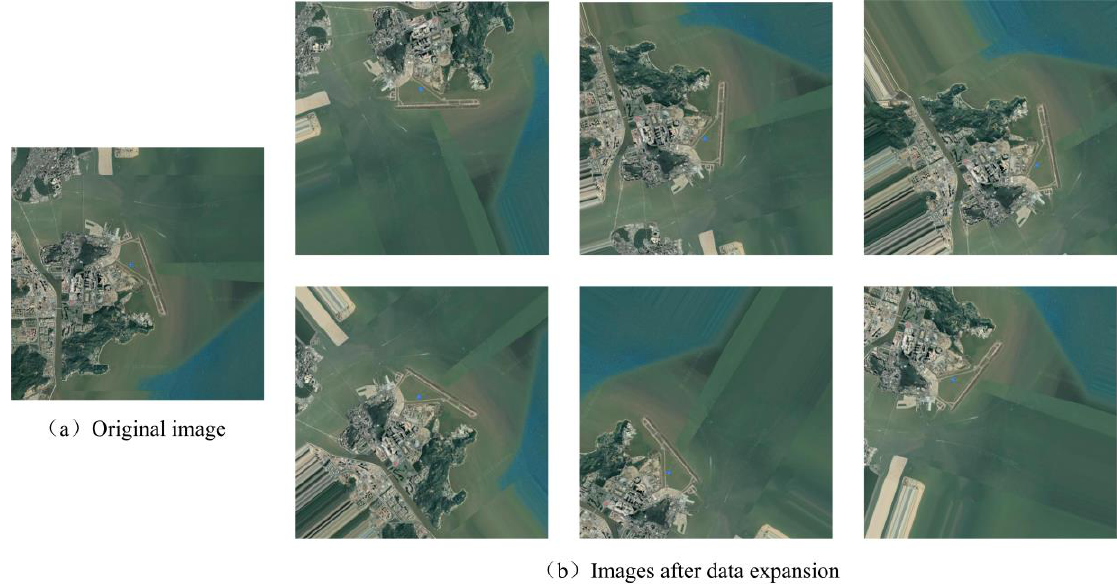
Figure 8. Schematic diagram of data expansion.